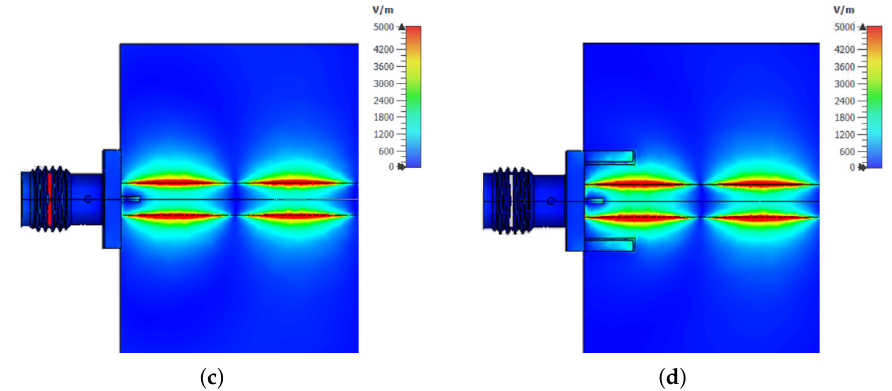
Figure 10. Top view of (cid:126) E -field distribution at 6.85 GHz where increased losses can be observed. ( a ) (cid:126) E -field resonance occurring at 6.85 GHz in the PCB 1 model (Figure 3a). ( b ) (cid:126) E -field resonance of PCB 2 occurring at 3.782 GHz. The resonance is caused by the ground metal at the top layer. ( c ) (cid:126) E -field distribution after removing top ground metal (PCB 3, Figure 3c). ( d ) (cid:126) E -field distribution at 6.85 GHz using vias (PCB 4) to connect the top and bottom ground (Figure